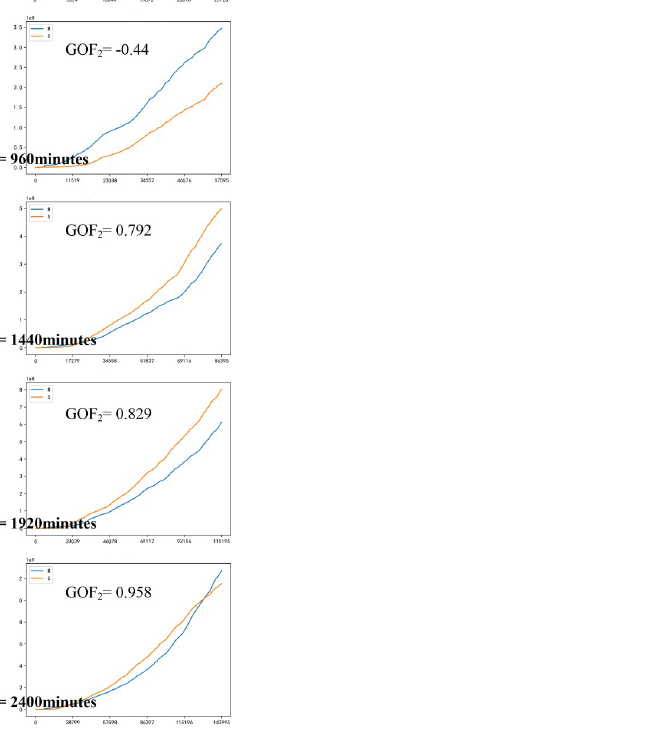
Fig 8. Model 0 ~ Model 4 demand trend